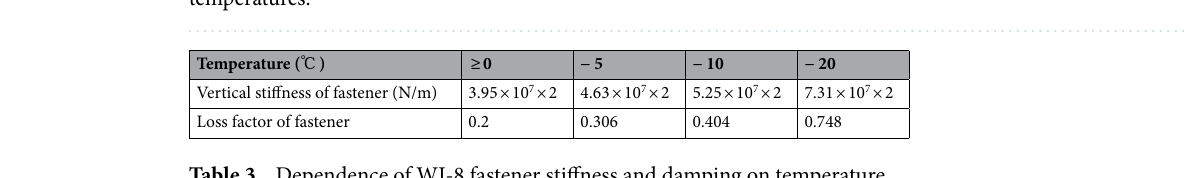
Table 3. Dependence of WJ-8 fastener stiffness and damping on